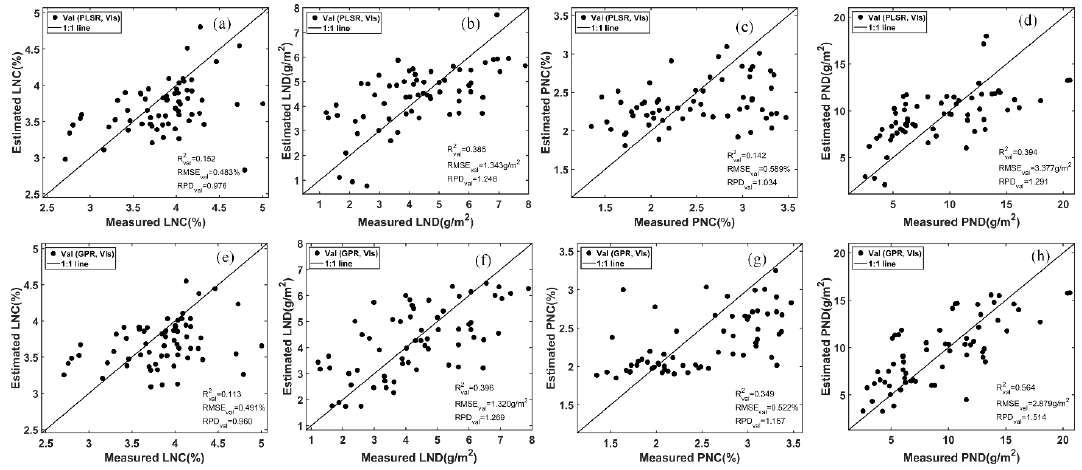
Figure 4. The predictive performance of ( a – d ) the partial least square regression (PLSR) and ( e – h ) Gaussian processes regression (GPR) models based on the combination of RGB-based VIs for winter wheat N status estimation.